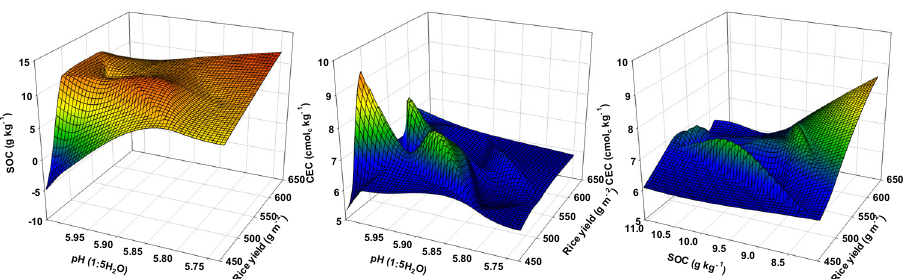
Figure 2. Correlations among rice yield and major soil characteristics.